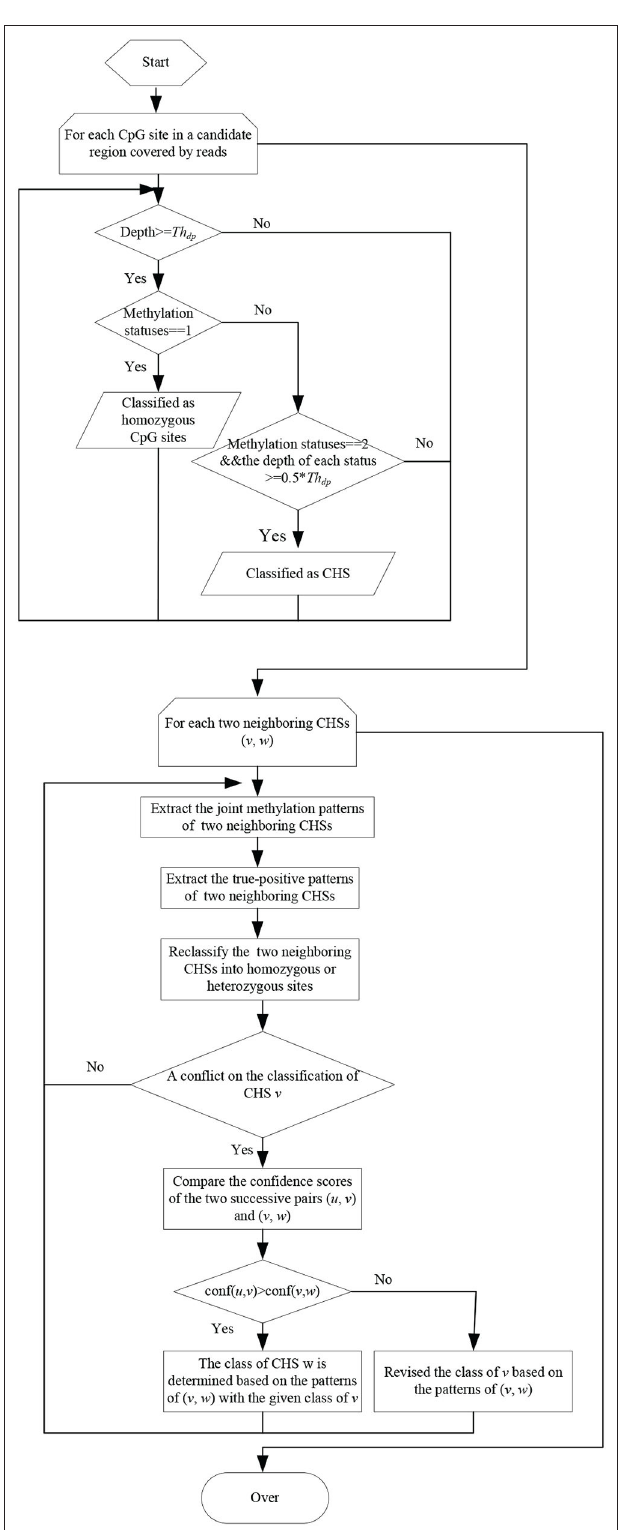
FIGURE 2 | The flowchart of classifying CpG sites into homozygous and heterozygous ones.